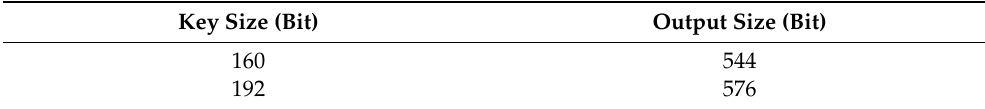
Table 6. Output size for the message m based on